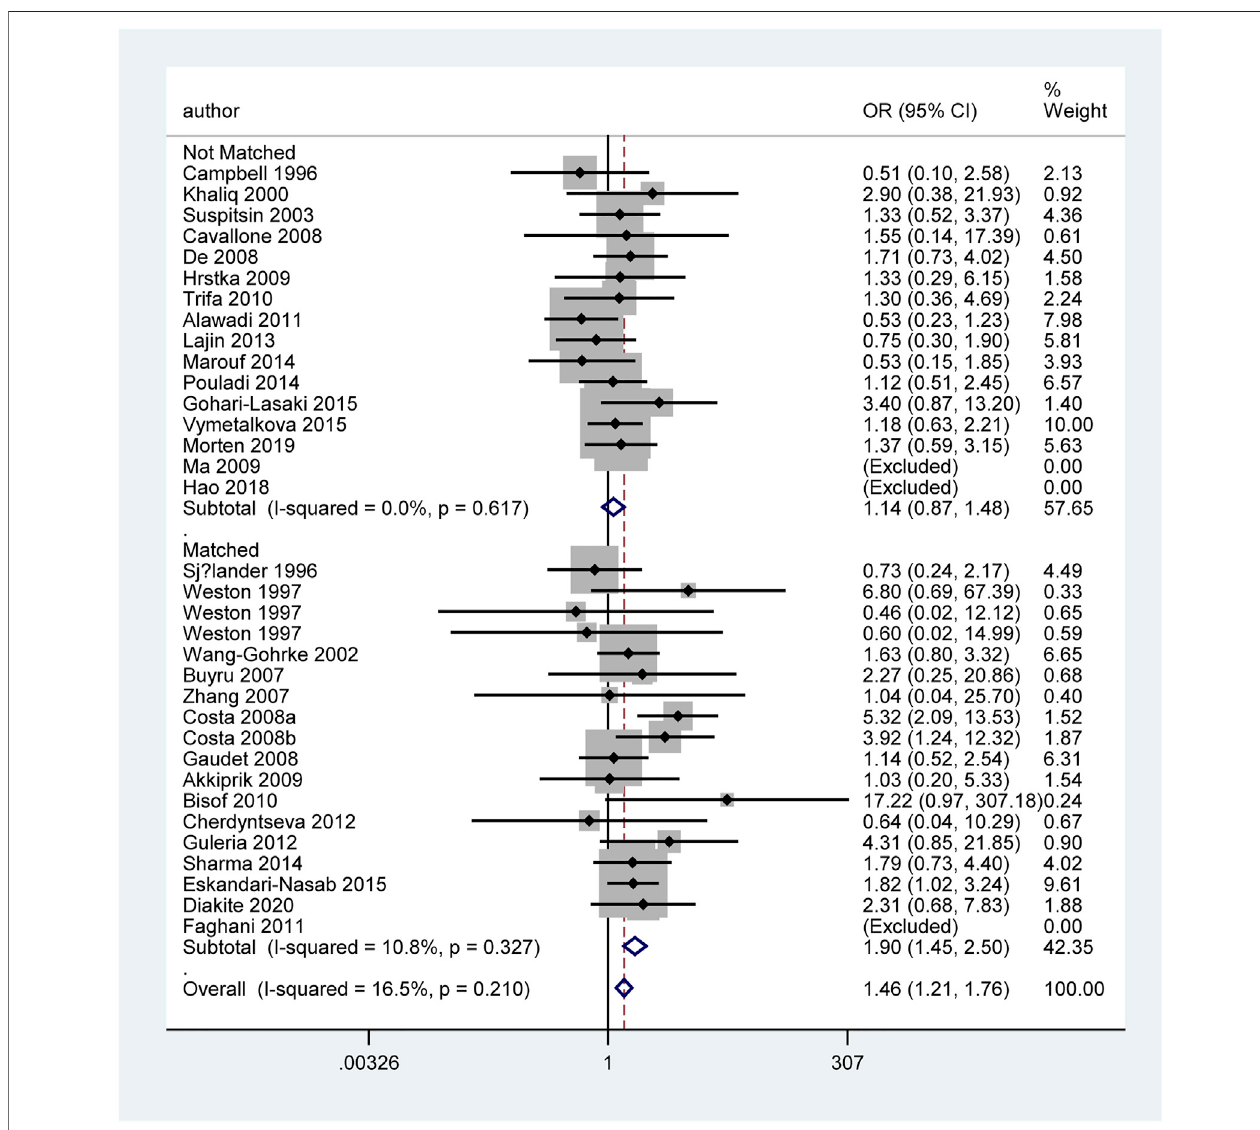
FIGURE 3 | Forest plot of the association between TP53 IVS3 16 bp polymorphism and BC risk in strati fi cation analysis (GG vs. CC).